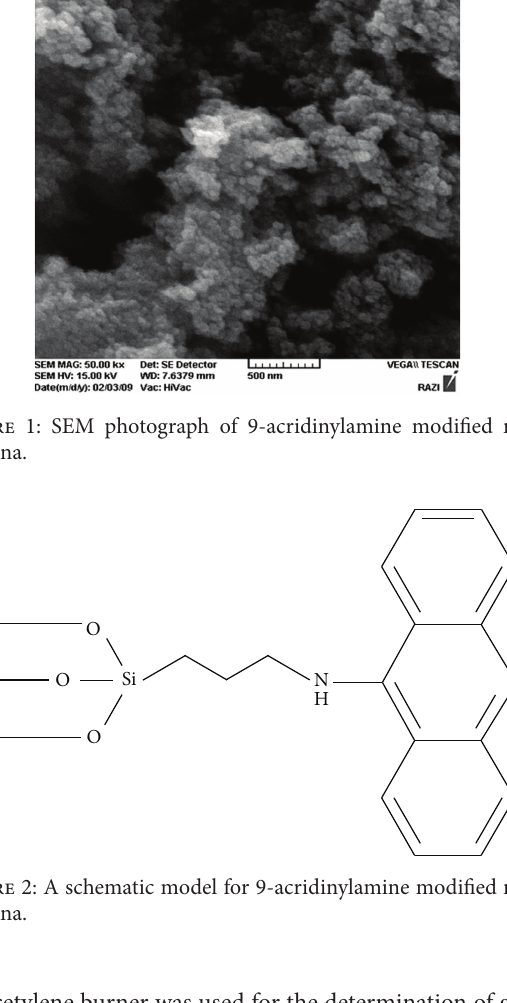
air acetylene burner was used for the determination of